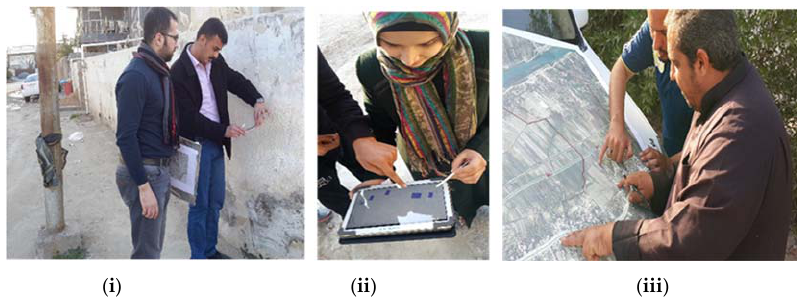
Figure 1. Data collection methods applied in different geographical contexts: (i) smartphone GPS in an urban centre; (ii) tablet computer in an urban centre; and (iii) paper aerial image in a rural area.